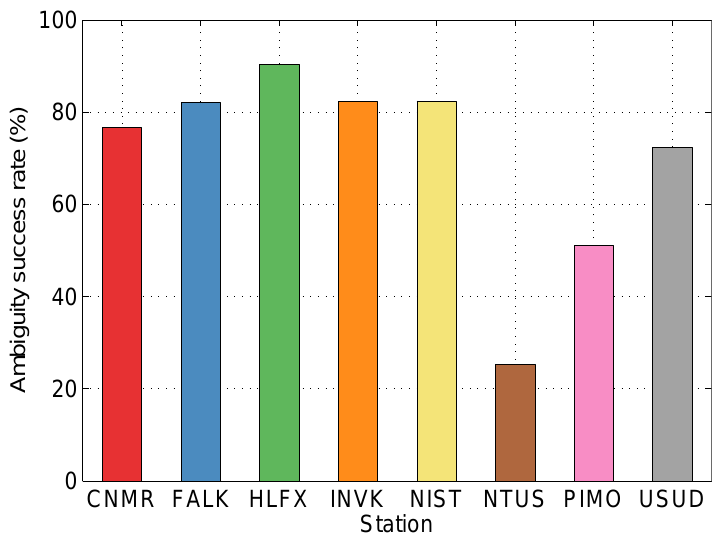
Figure 10. The ambiguity success rates at different stations in the post-processing PPP.